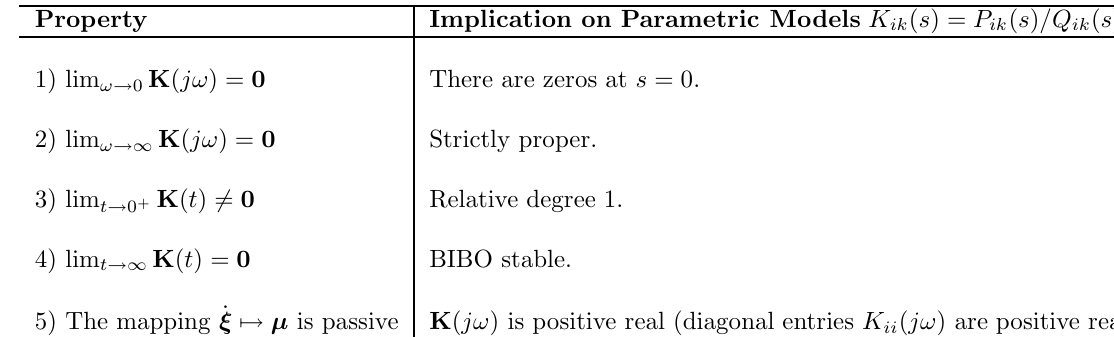
Table 1: Properties of Retardation